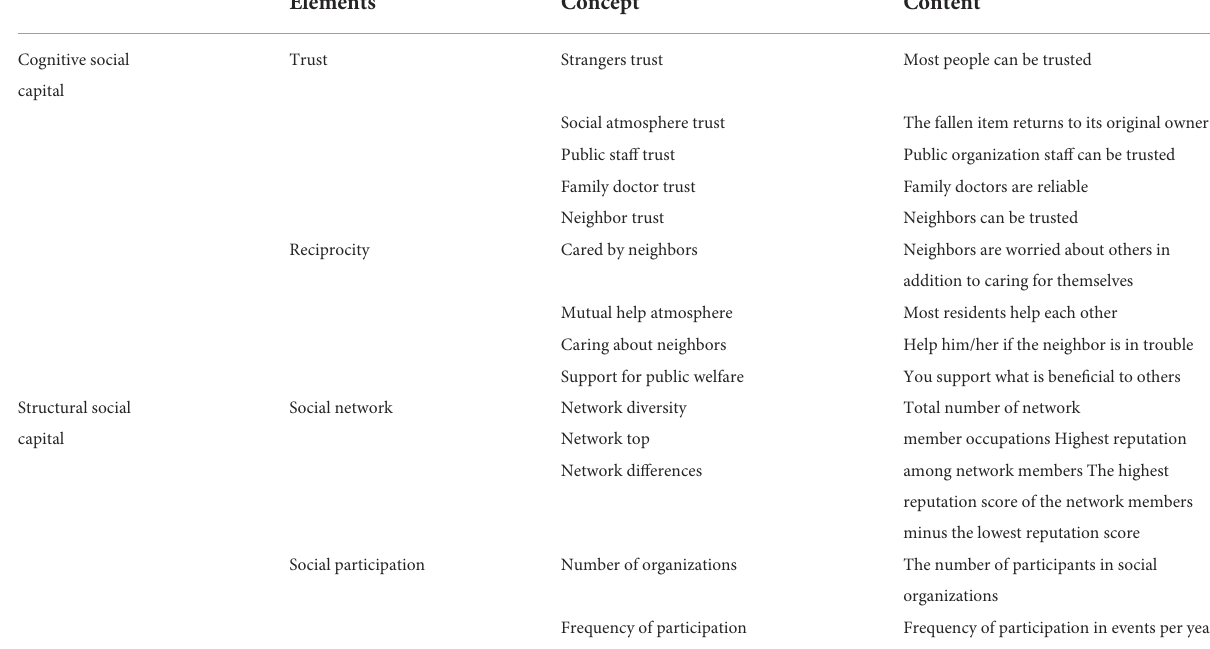
TABLE 2 Social capital